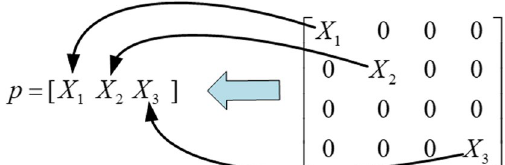
Fig. 2 Available matrix mapping